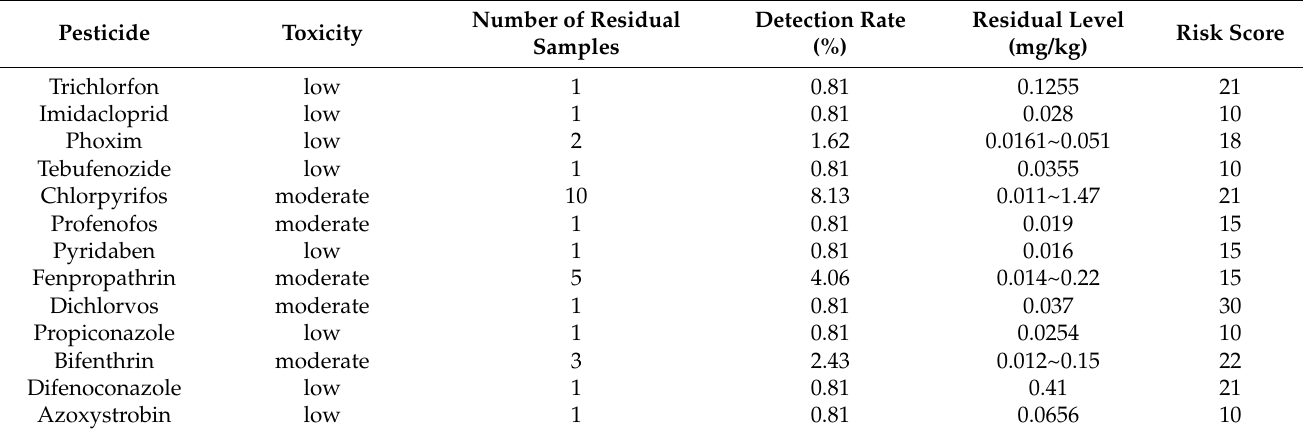
Table 6. Pesticide residue levels in coix